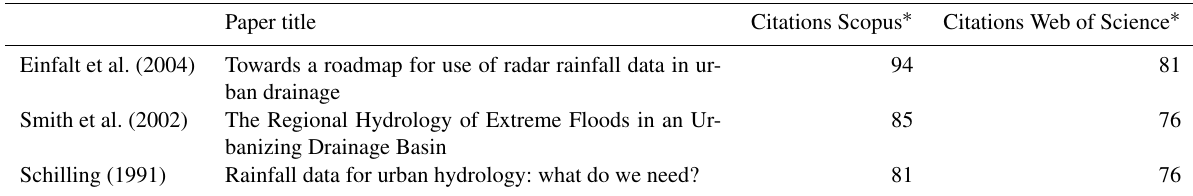
Figure 1. Scopus and Web of Science documents under search strings “ radar + urban drainage ” and “ radar + urban hydrology ”. Table 1. Most cited papers within radar and urban